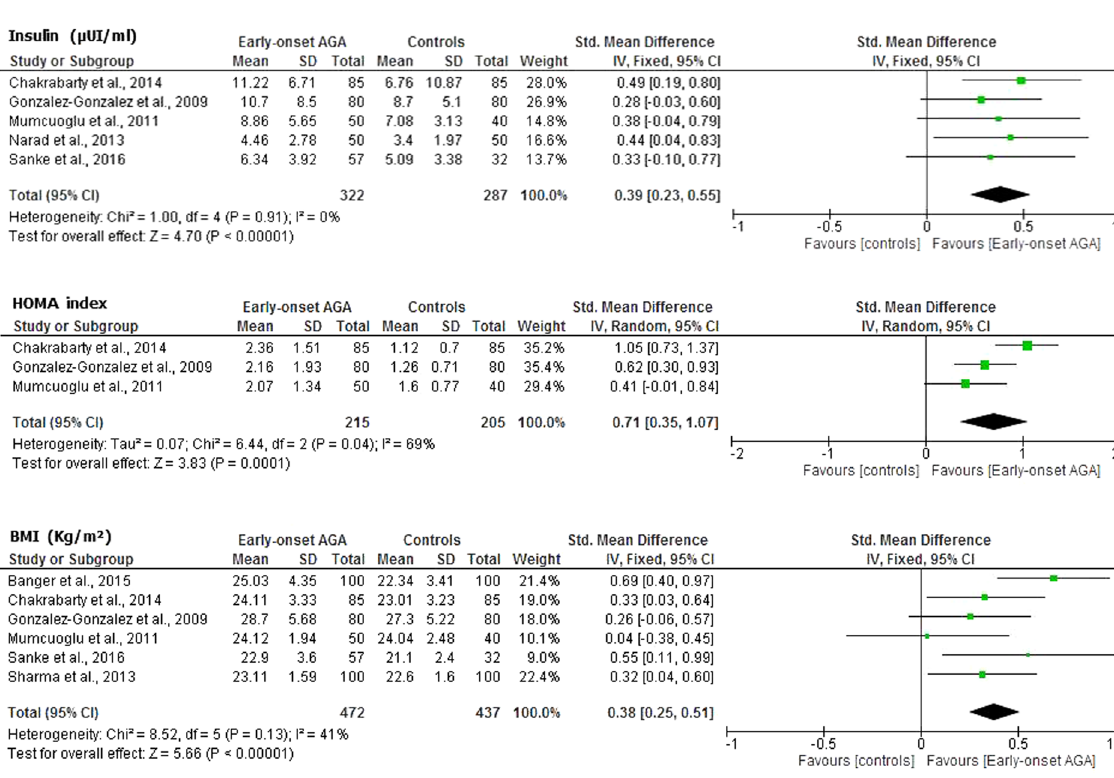
Figure 2. Glycemic profile and body mass index in young men with androgenetic alopecia compared to controls. Men with early-onset androgenetic alopecia younger than thirty-five years old showed significantly higher insulin serum levels, HOMA index, a marker of insulin-resistance, and body mass index values compared to age-matched controls. Insulin was expressed in µ UI/ml; Body mass index was expressed in Kg/m 2